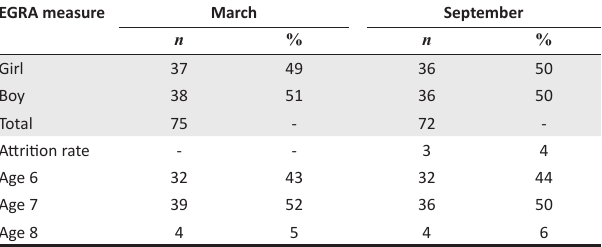
TABLE 1: Gender, age and attrition rate of the Grade 1 learners across